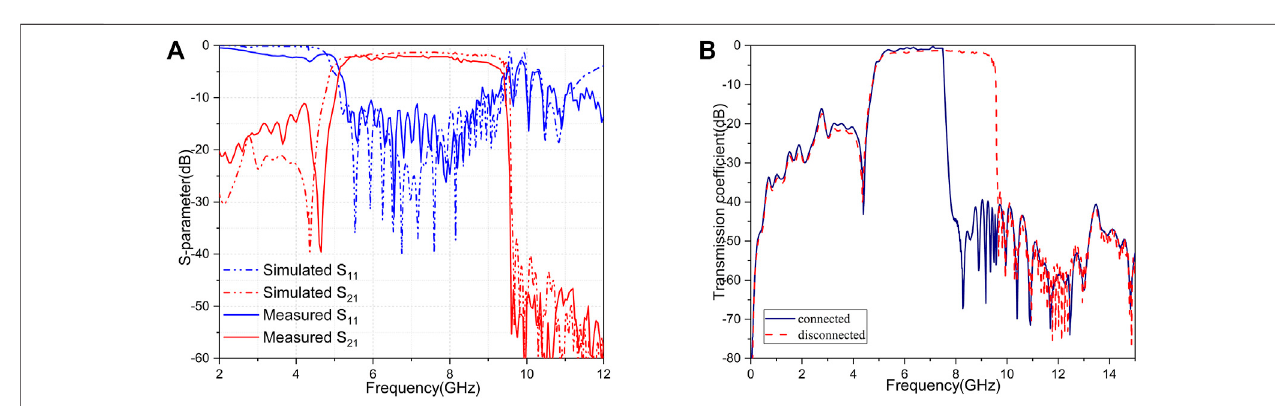
FIGURE 10 | (A) The S -parameters simulated and measured results of SSPP fi lter. (B) The transmission coef fi cient results of SSPP diode recon fi gurable fi lter in Figure 1B .